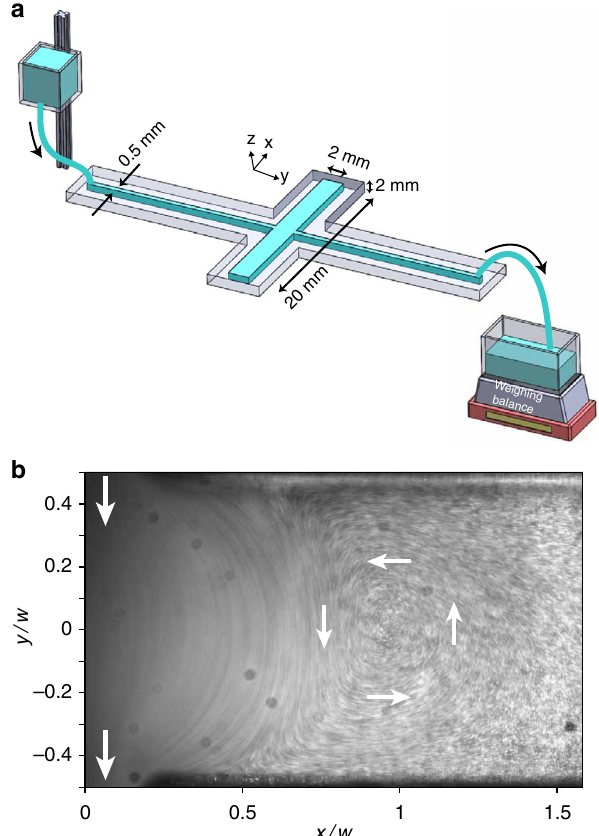
Fig. 1 Experimental setup and vortex fl ow in a rectangular cavity. a Schematic of the experimental setup (not to scale). b Particle streaks of the fl ow in a rectangular cavity ( e → 1) at Re = 0.07; see also corresponding Supplementary Movie 1. White arrows indicate the fl ow